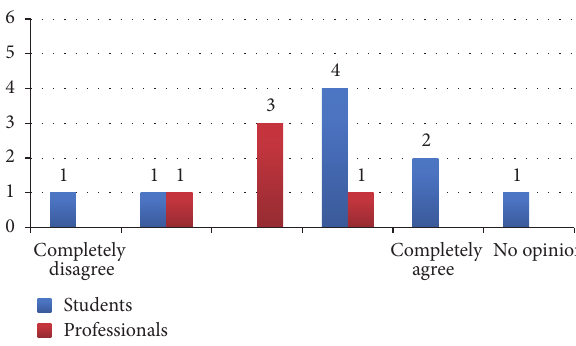
Figure 4: Once learnt, ECW/PUEA is very